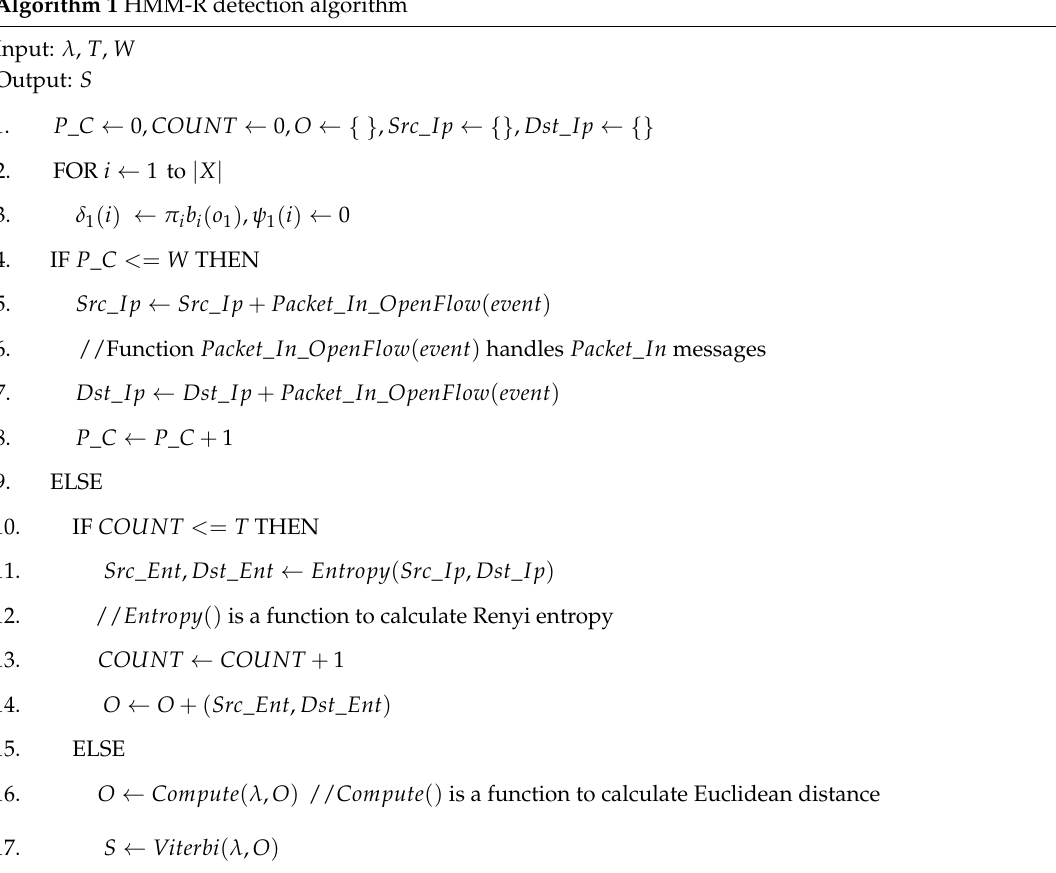
Algorithm 1 HMM-R detection algorithm